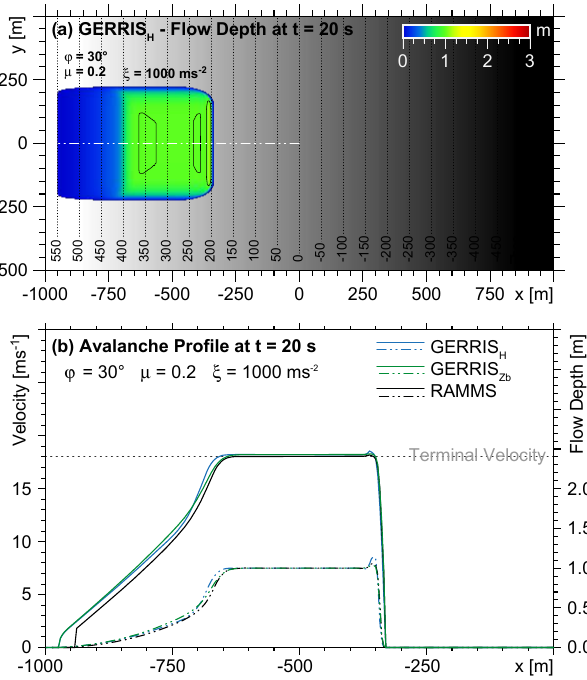
Figure 2. Comparison of two different numerical solutions of GERRIS with RAMMS for granular flow over a 30 ◦ dipping ramp for Voellmy parameters µ = 0 . 2 and ξ = 1000ms − 2 and an ini- tial flow depth h = 1m . (a) Two-dimensional representation of the ramp geometry and the flow depth of the fluid layer measured nor- mal to the surface after 20s. The white dashed-dotted line indicates the position of the longitudinal profiles shown in (b) . (b) Longi- tudinal profiles of three different numerical models showing flow velocity (solid lines) and flow depth (dashed-dotted lines). The gray dashed line indicates the theoretical terminal velocity according to Eq. (28). GERRIS-based models (blue and green lines) apply gra- dients of fluid surface (GERRIS H ) and gradients of the topography (GERRIS Zb ) respectively, and black lines are results RAMMS as